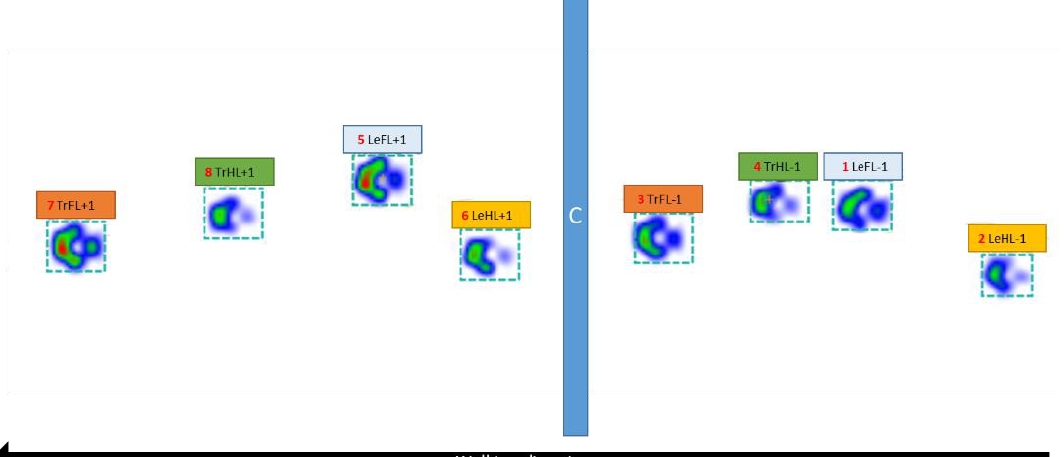
Figure 1. Labeling of the limbs when crossing a single cavaletti (dog 1). Blue — leading forelimb, yellow — leading hindlimb, orange — trailing forelimb, green — trailing hindlimb; −2— first stance phase before the cavaletti, −1— second stance phase before the cavaletti, +1 — first stance phase after the cavaletti. The red numbers indicate the order in which the paws touched the plate.